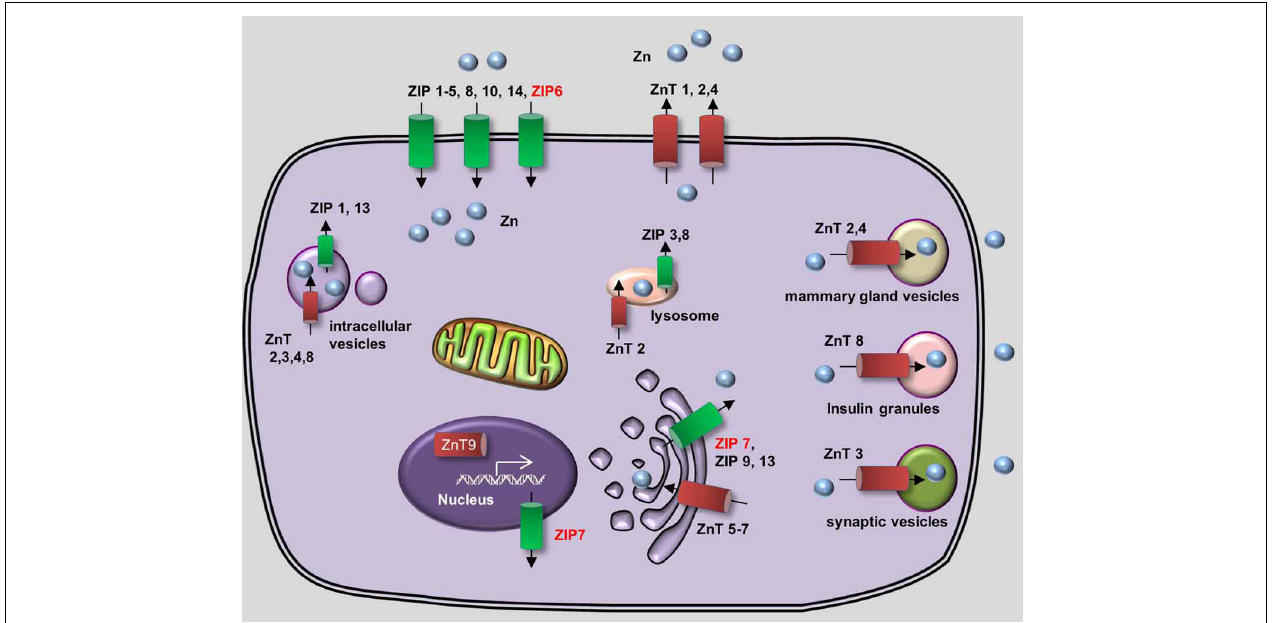
FIGURE 2 | Generalized overview of zinc metabolism in vertebrate cells. Zinc Transporters (ZnTs) downregulate intracellular zinc levels by exporting zinc through the plasma membrane (ZnT1, ZnT2, and ZnT4) or by transporting zinc into various intracellular compartments, including lysosomes (ZnT2), the Golgi apparatus (ZnT5-7), mammary gland vesicles (ZnT2 and ZnT4), insulin granules (ZnT8), and synaptic vesicles (ZnT3). In addition, ZnT9 can